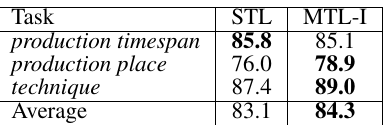
Table 6. Overall accuracies [%] of the second series of experiments.